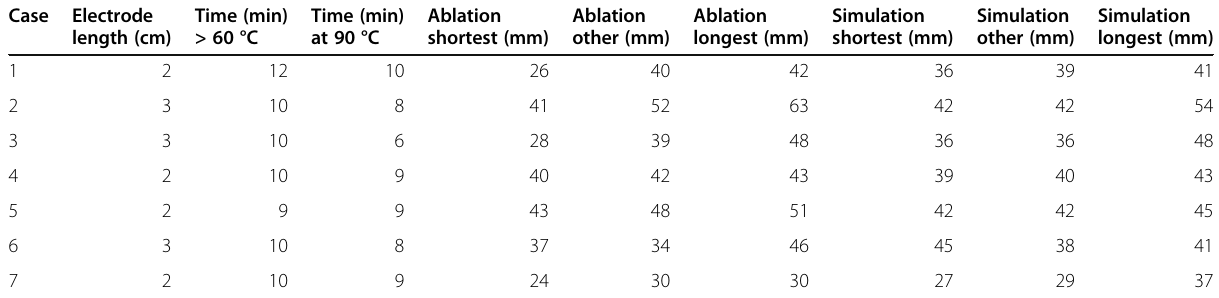
Table 2 Cases, length of the electrode used, timings, and the resulting ablation diameters from the radiological measurements and the simulations